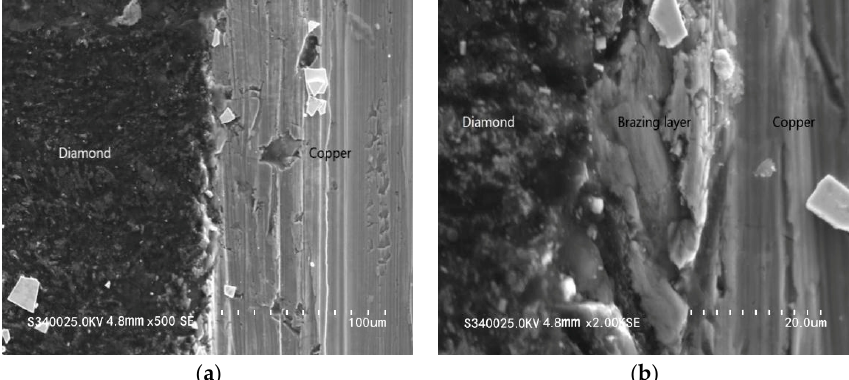
Figure 4. Cross-sectional images of the composite anode under scanning electron microscopy (SEM). ( a ) Cross-sectional image of the soldering layer, magnified 500 times; ( b ) cross-sectional image of the soldering layer, magnified 2000